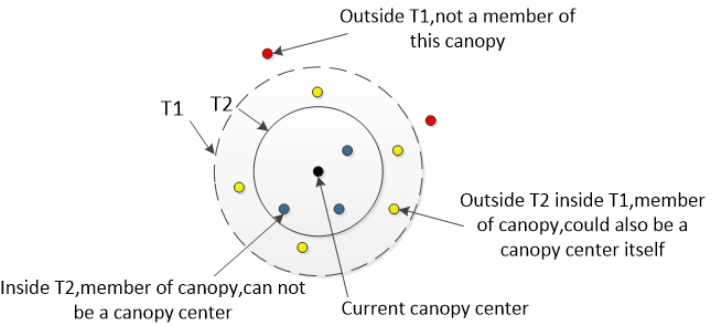
Figure 4. Canopy